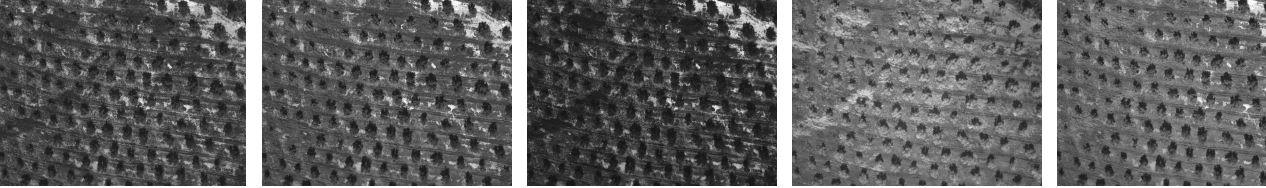
Figure 2. Capture 0, as provided by the multispectral camera: one image for each of the blue, green, red, near-infrared and red-edge bands ( left to right ), where the large amount of plant cover in the ground is clearly